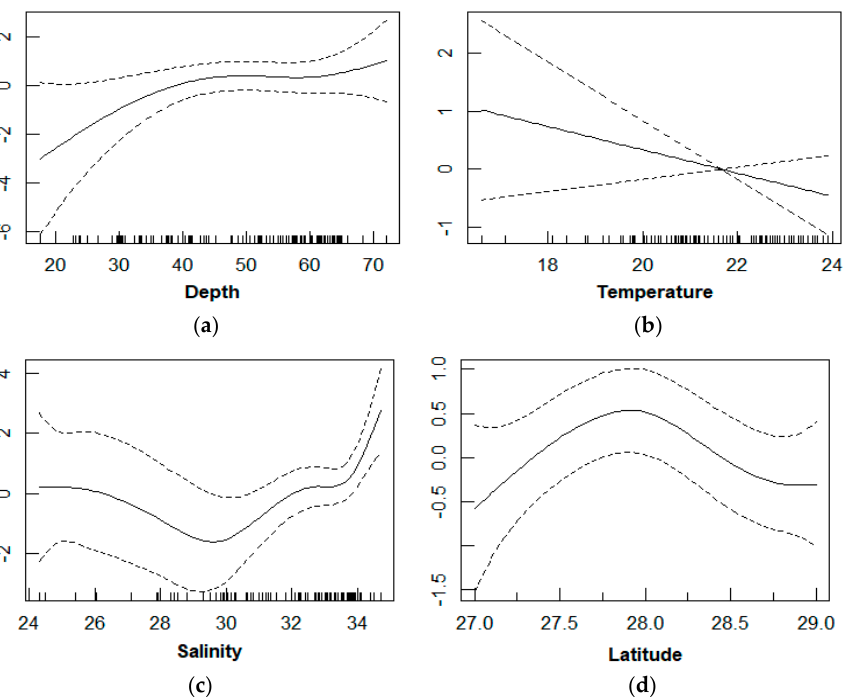
Figure 4. Relationship between the density of D. maruadsi and environmental factors in coastal waters of southern Zhejiang at seasonal scales (Autumn): ( a ) effect of depth; ( b ) effect of temperature; ( c ) effect of salinity; and ( d ) effect of latitude. Dashed lines show 95% confidence intervals.